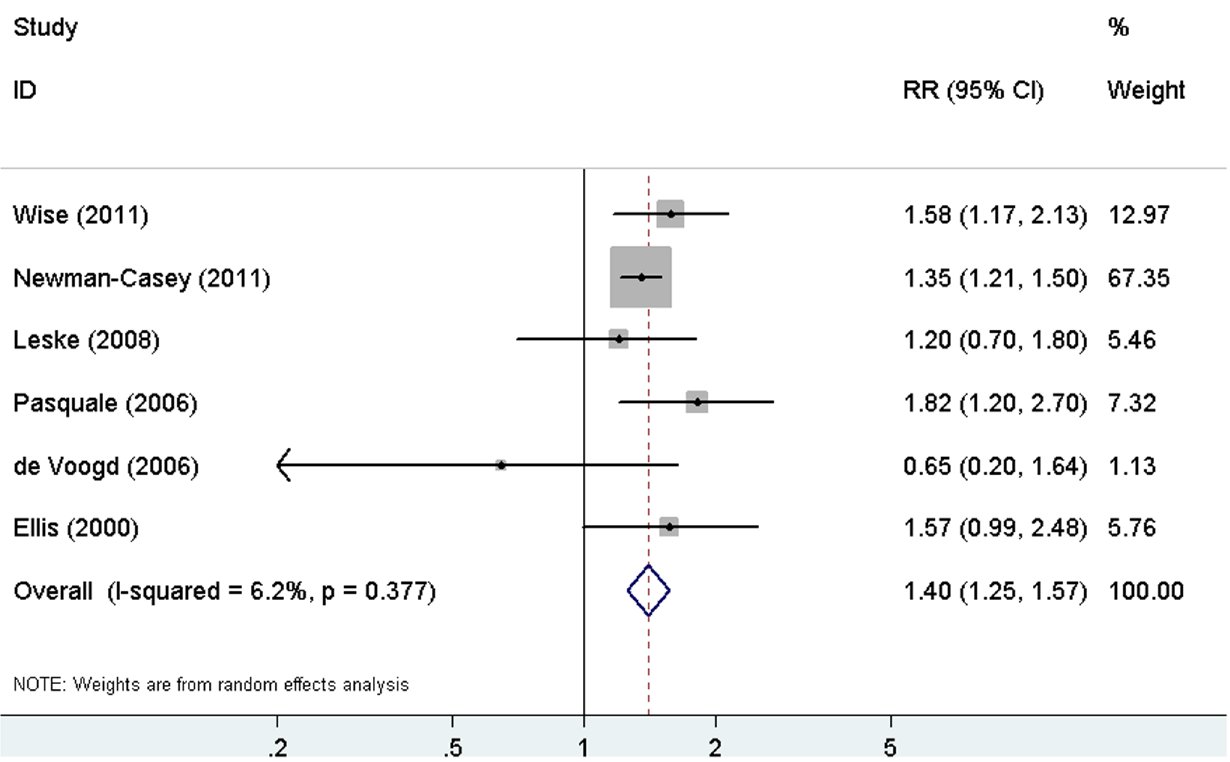
Figure 3. Forest plot of the risk estimates of the association between DM and POAG in the cohort studies. RR=risk ratio; CI=confidence interval; DM=diabetes mellitus; POAG=primary open-angle glaucoma.